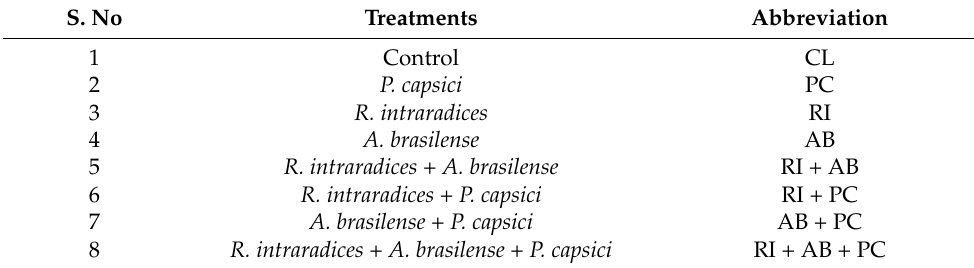
Table 1. Description of the treatments and abbreviations used in the study. S.